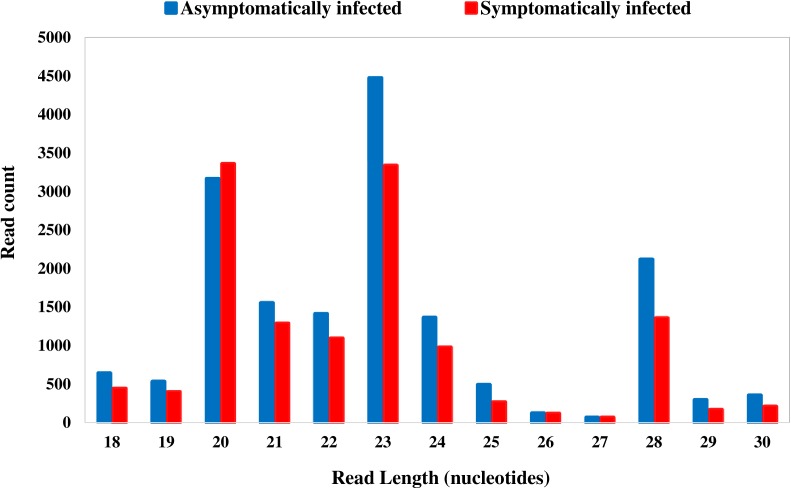
Length distribution of reads mapped onto the G. pallidipes genome from asymptomatically (blue bar) and symptomatically (red bar) infected flies.